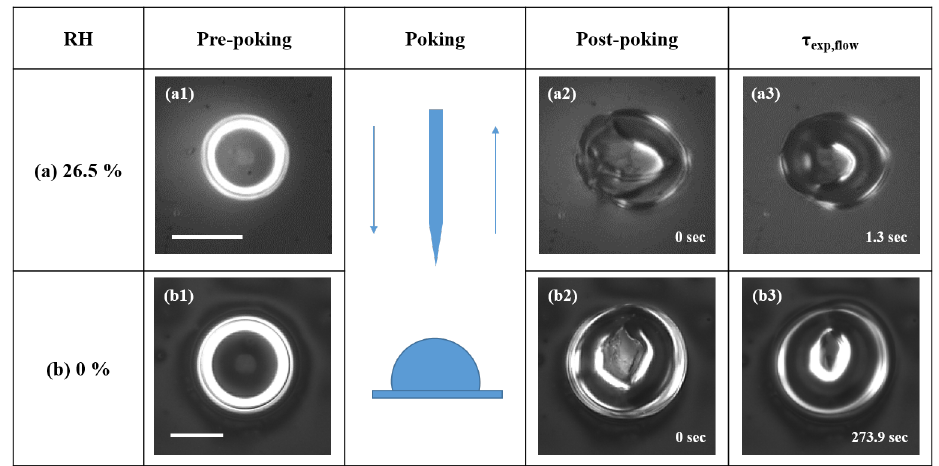
Figure 4. Optical images from typical poke-flow experiments on isoprene-derived SOM at (a) 26.5% RH and (b) 0% RH. Panels (a1) and (b1) show pre-poking; panels (a2) and (b2) show post-poking immediately after the needle has been removed (time set = 0s); panels (a3) and (b3) show the experimental flow time, τ ( exp , flow ) , when the diameter of the hole has decreased to 50% of its initial size. Size of the scale bar is 20µm. Table 2. Physical parameters used to simulate material flow in the poke-flow experiments. R and r indicate the radius of a tube and the radius of an inner hole,